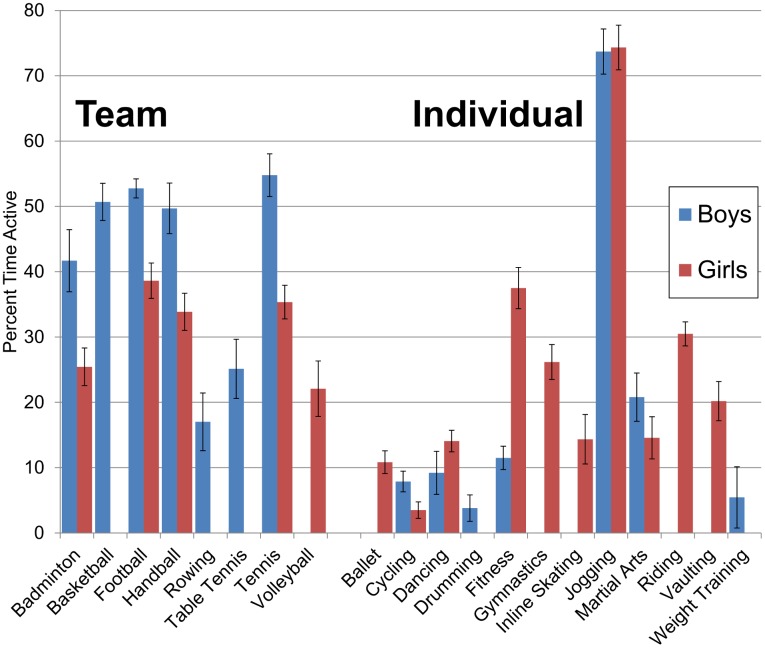
Time in MVPA During Sport.MVPA as determined in Freedson‘s accelerometric algorithm (Freedson et al 2005, #19). Sports shown if that sex had >10 episodes during recording. Error bars for standard error of the mean.